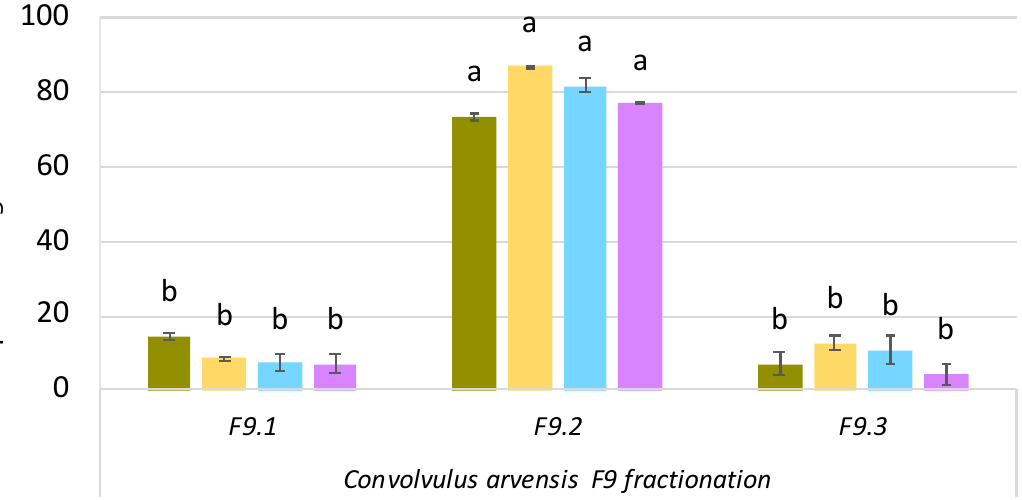
Figure 2. ( A ) Inhibition of broomrape radicle growth induced by fractions (F9.1, F9.2 and F9.3) ob- tained from the phytotoxic ninth fraction of the extract of roots of Convolvulus arvensis expressed as a percentage with respect to the control GR24. ( B – I ) Photographs illustrating the effects of fraction F9.2 in radicles of ( B ) Orobanche crenata , ( C ) Orobanche cumana , ( D ) Orobanche minor and ( E ) Pheli- panche ramosa in comparison with the effect of the control treatment in ( F ) Orobanche crenata , ( G ) Orobanche cumana , ( H ) Orobanche minor and ( I ) Phelipanche ramosa . Analysis of variance was applied to transform replicate data. For each broomrape species, bars with different letters are significantly different according to the Tukey test ( p = 0.05). Error bars represent standard error.